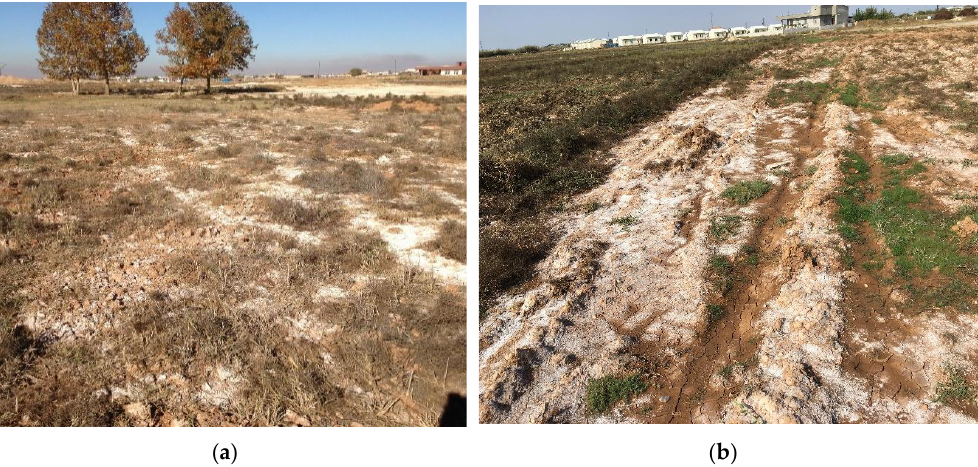
Figure 4. ( a , b ) Salinization problems in di ff erent locations of Harran Plain (Source: Prof. Dr. M. Ali